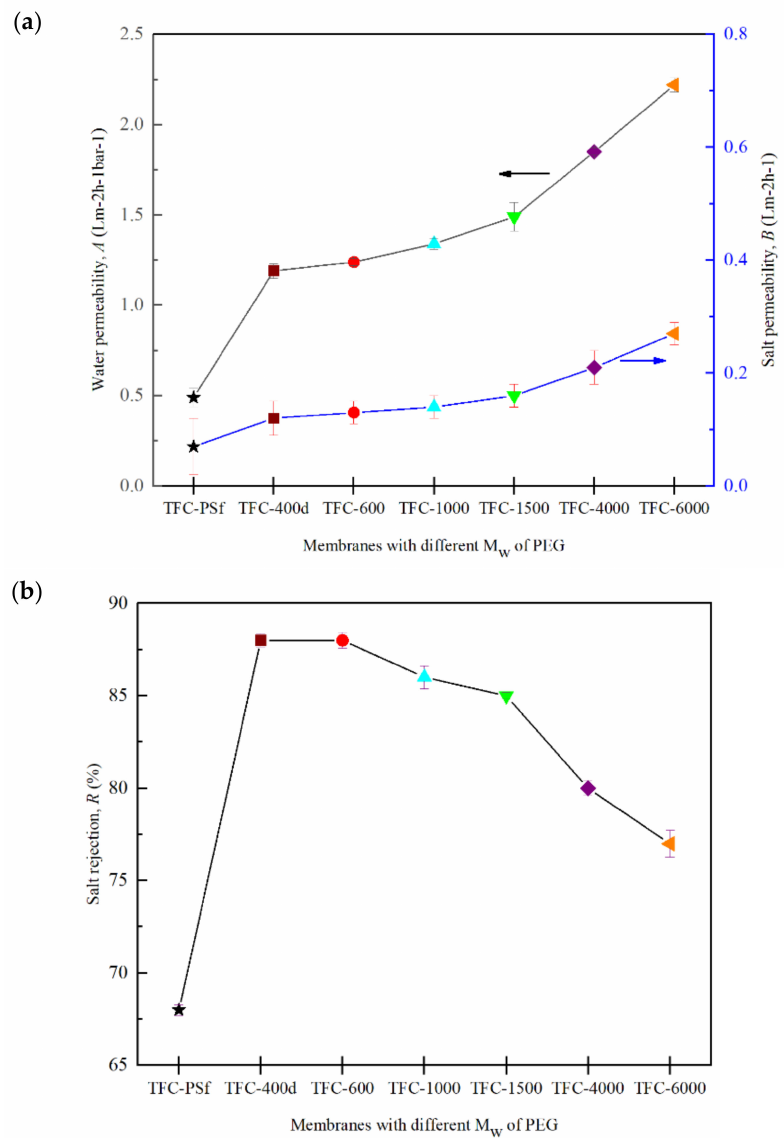
Figure 7. ( a ) Water permeability, A , and salt permeability, B ; ( b ) salt rejection, R , for modified TFC membranes with different M w s of